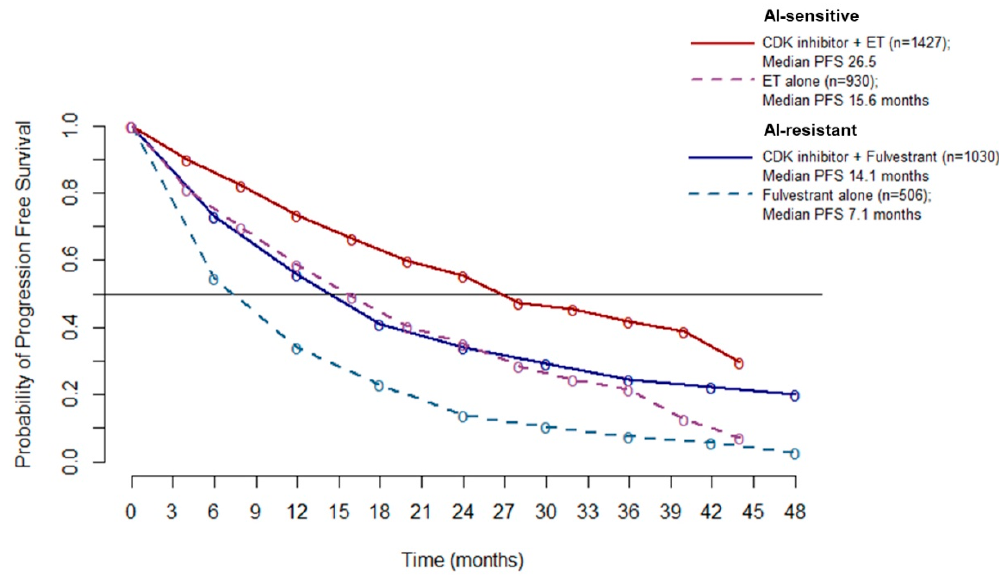
Figure 5. Meta-curves of PFS for AI-sensitive and AI-resistant patients: PFS is significantly longer in patients treated with CDK4/6 inhibitor than patients treated with ET alone (dashed lines), in both AI sensitive (red line and violet dashed line) and AI resistant (blue line and azure dashed line) group.